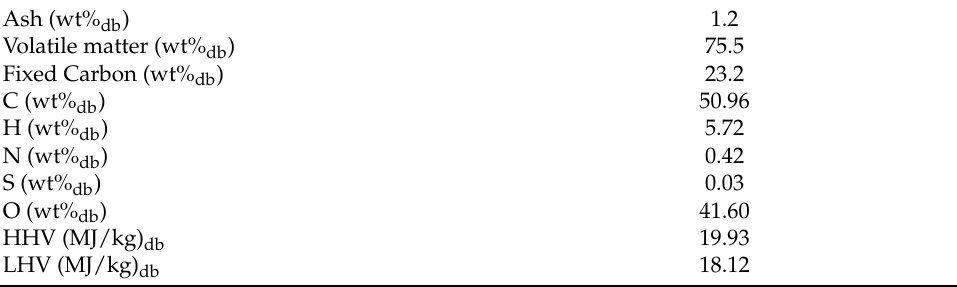
Table 1. Proximate and ultimate analyses of hazelnut shells (moisture content = 8.00%.).